Question: Identify the chart type used in this figure.
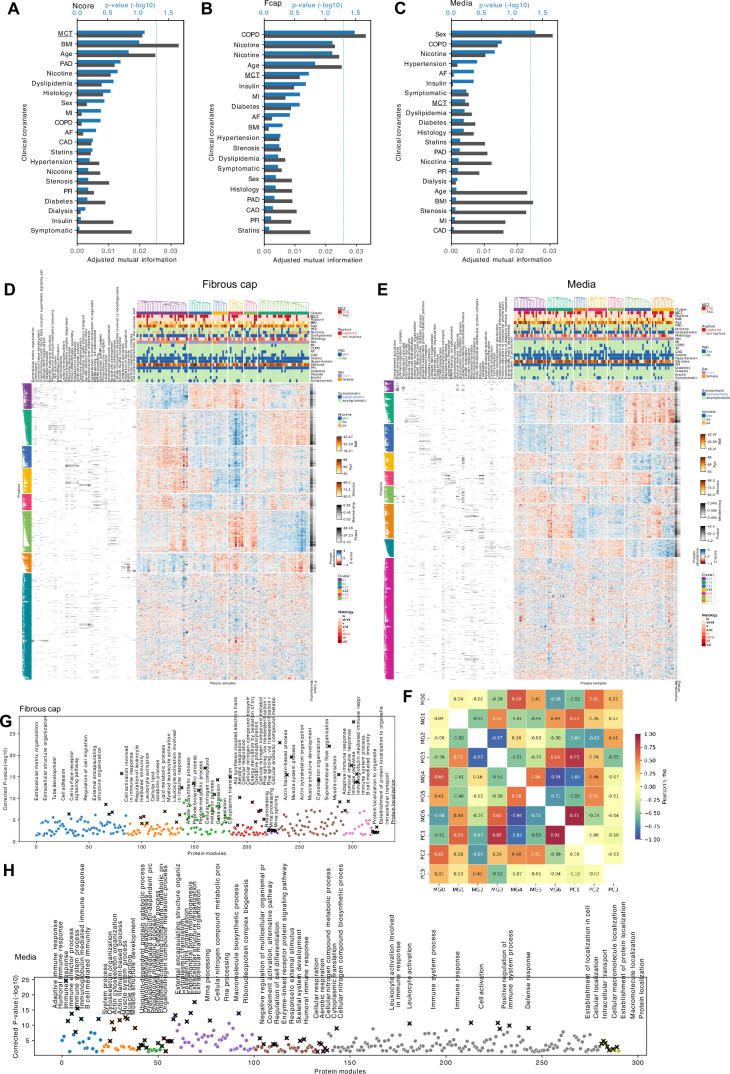
Answer: heatmap